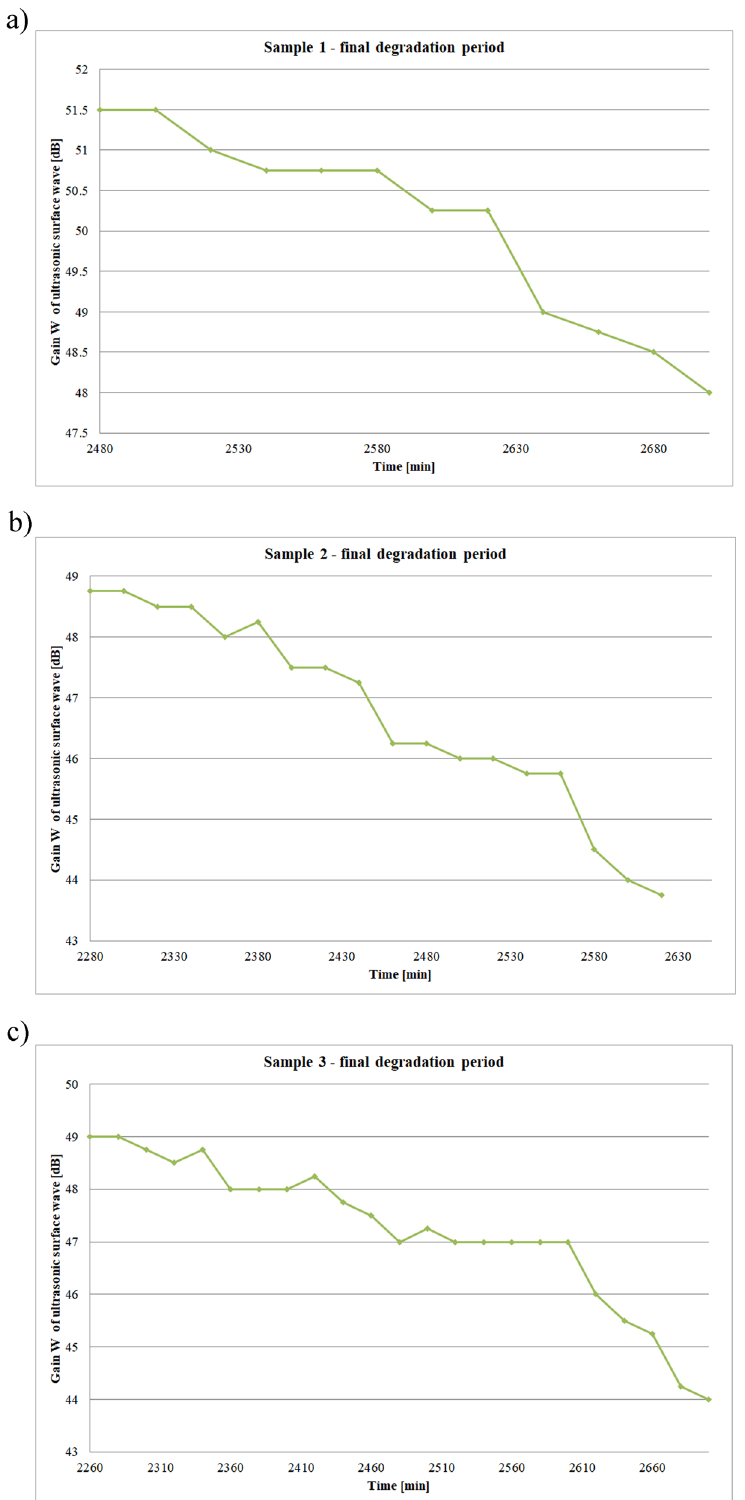
Figure 7: Course of ultrasonic wave gain during the degradation process of the coating – substrate joint – the last period until the coating completely detaches from the substrate: ( a ) sample 1, ( b ) sample 2 and ( c ) sample